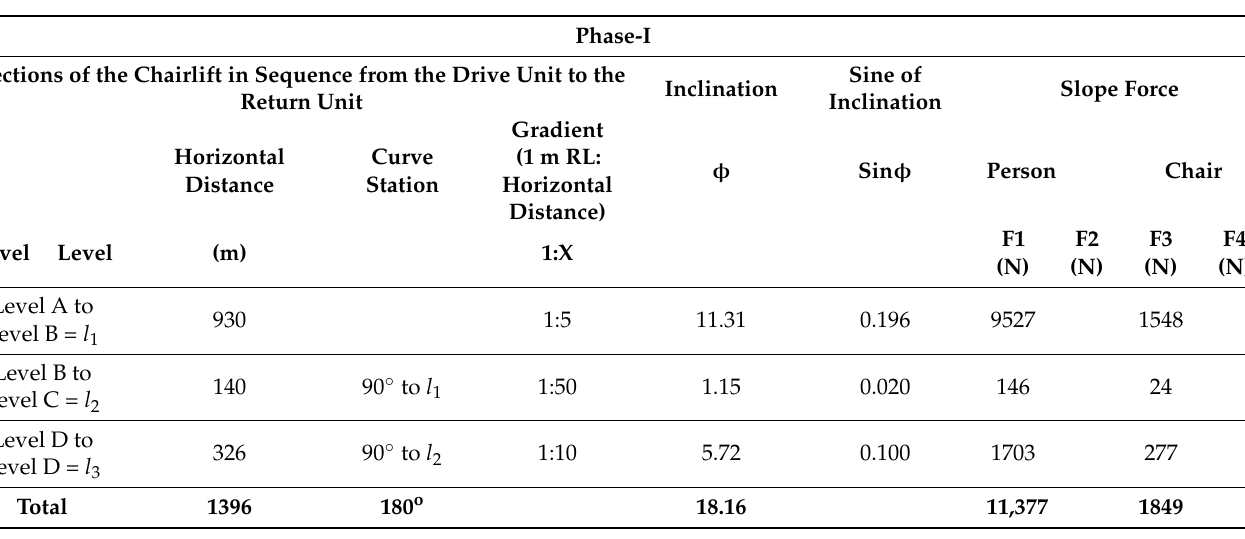
Table 2. Phase I Man-rider Installation.